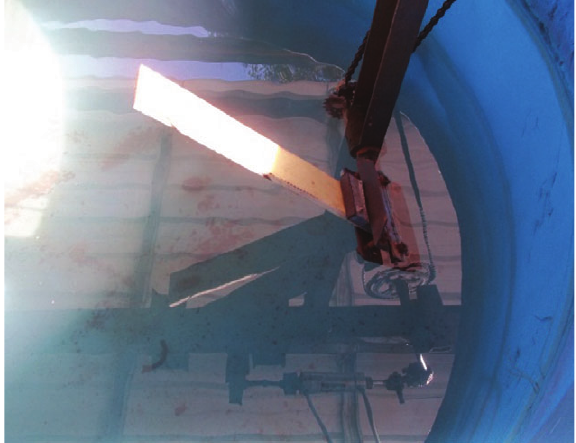
Figure 4 Slam testing